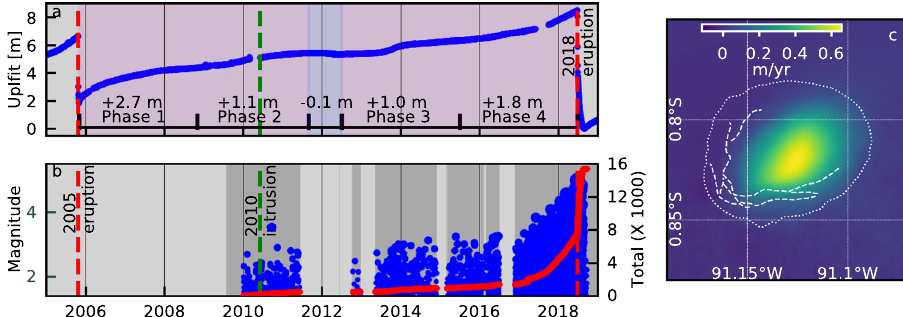
Fig. 2 Deformation and seismicity during the pre-eruptive phase at Sierra Negra volcano. A Vertical component of deformation recorded at cGPS stations GV02 and GV04 ( ‘ Methods ’ ). Vertical dashed lines indicate timing of the 2005 eruption (red), 2010 deep intrusion (green), and 2018 eruption (red). B Estimated earthquake magnitudes (blue circles) and total number of M > 1.4 earthquakes recorded at VCH1 (red line). C Radar line-of-sight average velocity between 13 March 2014 and 07 June 2018 from Sentinel-1 InSAR ( ‘ Methods ’ ).